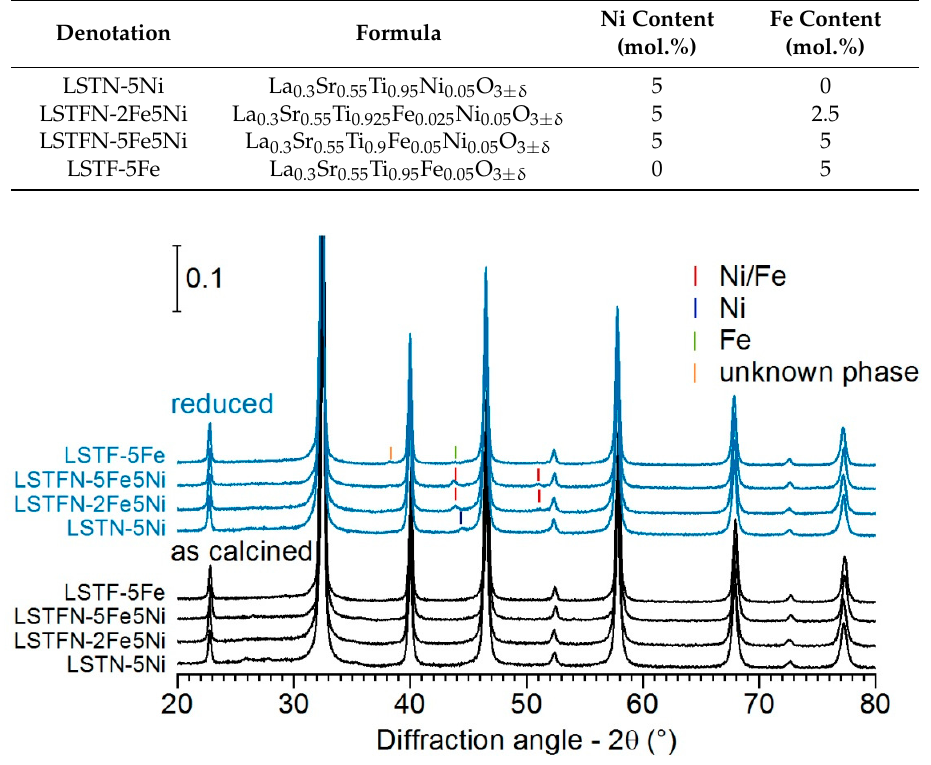
Table 1. Sample denotations and metal content of La 0.3 Sr 0.55 Ti 1-x-y Fe x Ni y O 3 ± δ -type samples. Denotation